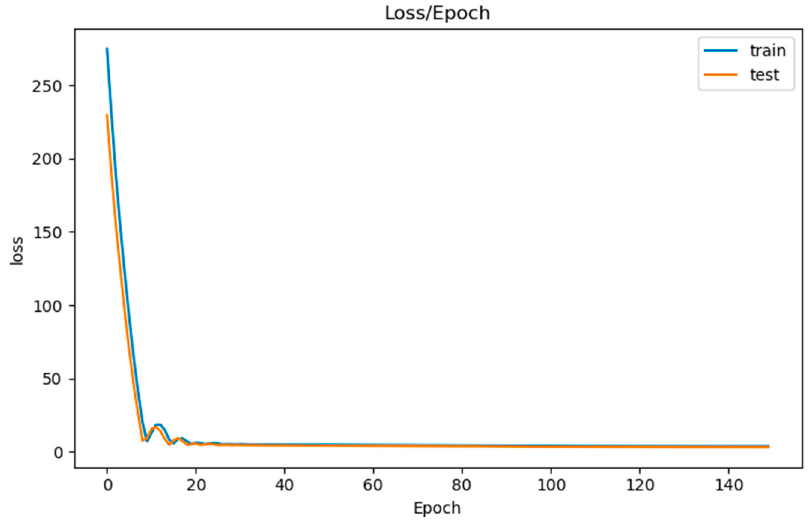
Figure 11. Loss/epoch results.